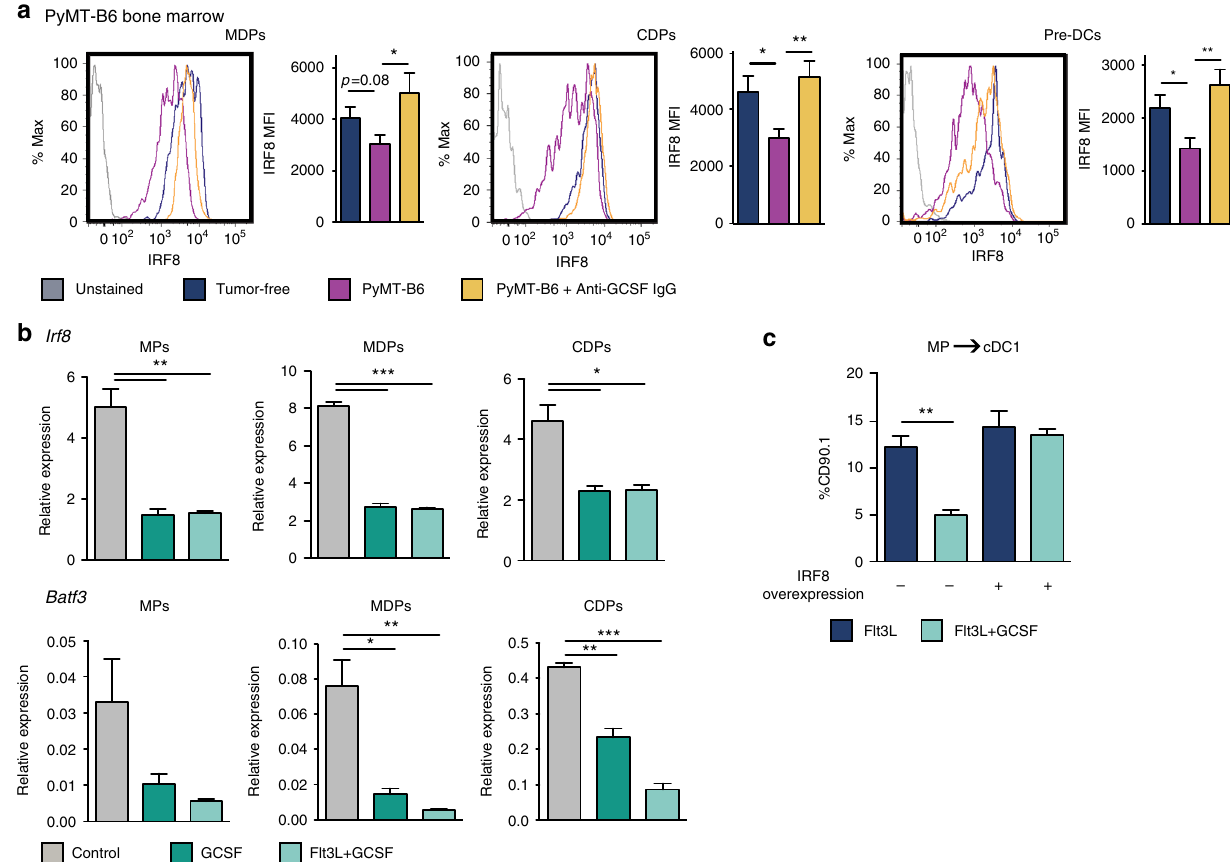
Fig. 7 GCSF regulates IRF8 in dendritic cell progenitors. a IRF8 measured in BM MDPs, CDPs, and pre-DCs of tumor-free mice, orthotopic PyMT-B6 tumor- bearing end-stage mice, and orthotopic PyMT-B6 tumor-bearing end-stage mice treated for 2 weeks with 50 μ g anti-GCSF IgGs 3 × /week; n = 6/group. Data are representative of two independent experiments. End stage is de fi ned in the Methods. b MPs, MDPs, and CDPs treated with 100 ng/ml GCSF and/ or 100 ng/ml Flt3L for 24 h. Analyzed by RT-qPCR for Irf8 and Batf3 . Data are representative of two independent experiments consisting of three wells per condition. c CD45.2 + Lin - Sca1 − cKit + MPs transduced with CD90.1 IRF8 overexpression vector or CD90.1 empty vector control were cultured on CD45.1 + BM feeder culture in the presence of 100 ng/ml Flt3L and/or 100 ng/ml GCSF for 3 days. Final cultures were analyzed for cDC1s (Live CD45.2 + CD90.1 + CD45.1 - MHCII + CD11c + Sirp α - CD24 + ). Data are representative of three independent experiments consisting of three wells per condition. Error bars represent mean + / − s.e.m. or box plot; * p < 0.05, ** p < 0.01, *** p < 0.001 by unpaired two-sided Student ’ s t